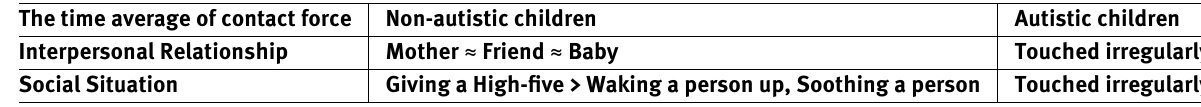
Table 2. The experimental result of the time average of contact force